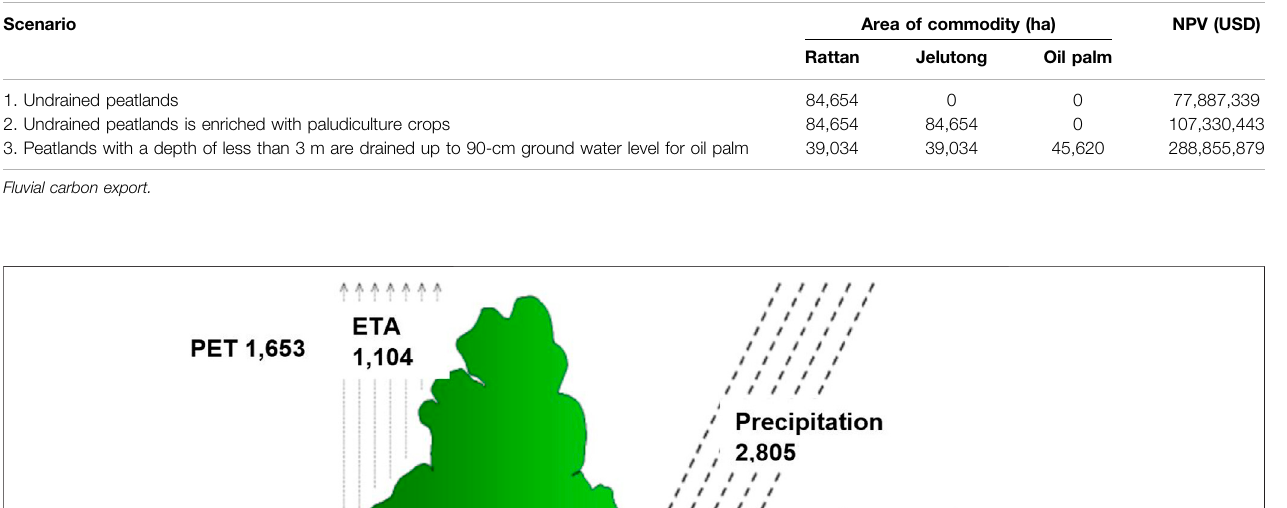
TABLE 4 | Provisioning service in each scenario.